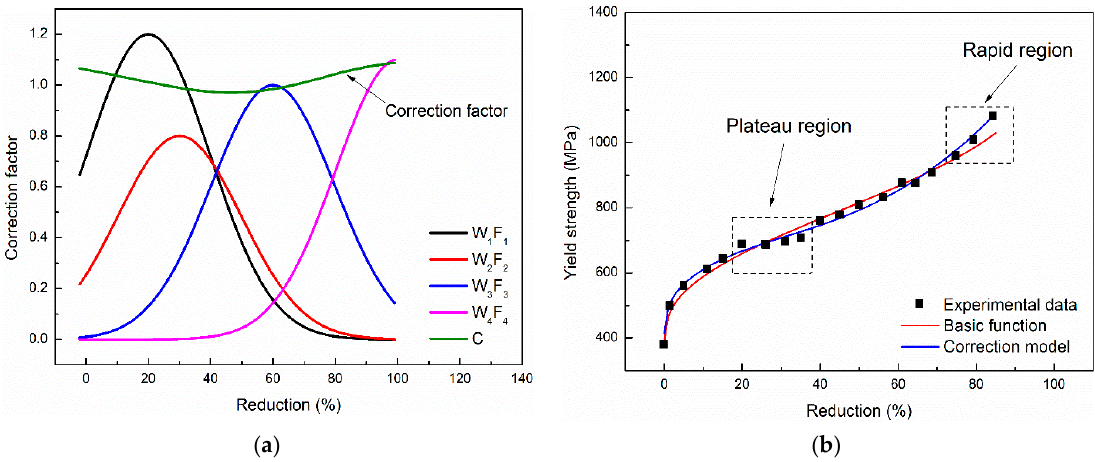
Figure 4. The ( a ) results of W l F l and C and ( b ) deformation resistance curve corrected by the ANN.